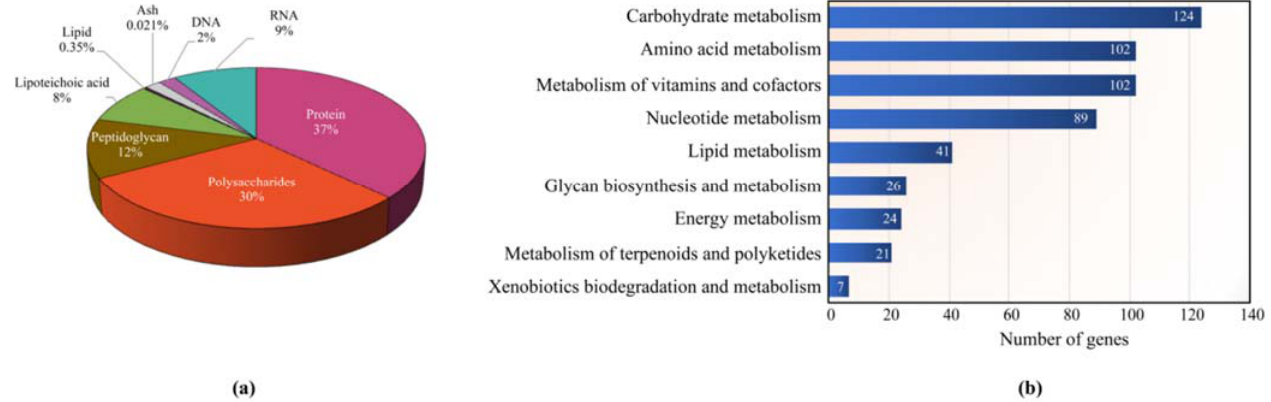
Figure 1. The i TN656 metabolic features in context of biomass composition and metabolic functional categories. ( a ) Metabolic precursors involving in biomass synthesis. ( b ) The horizontal bar chart shows the number of genes devoted to different metabolic functional categories. Table 1. Comparative characteristics of genomes towards metabolic networks of different strains of L. reuteri